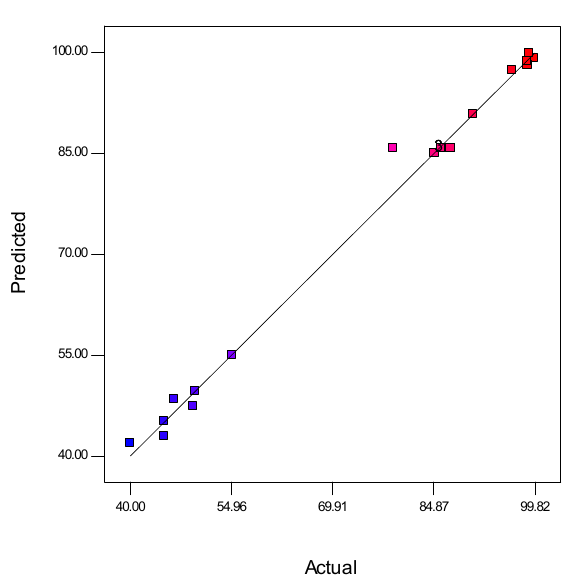
Figure 4. Analysis of predicted and actual response for oil rejection (%). Blue dots indicate <50% favours lower interaction between predicted and actual values of oil rejection and red dots indicate >80% favours higher interaction between predicted and actual values of oil rejection.